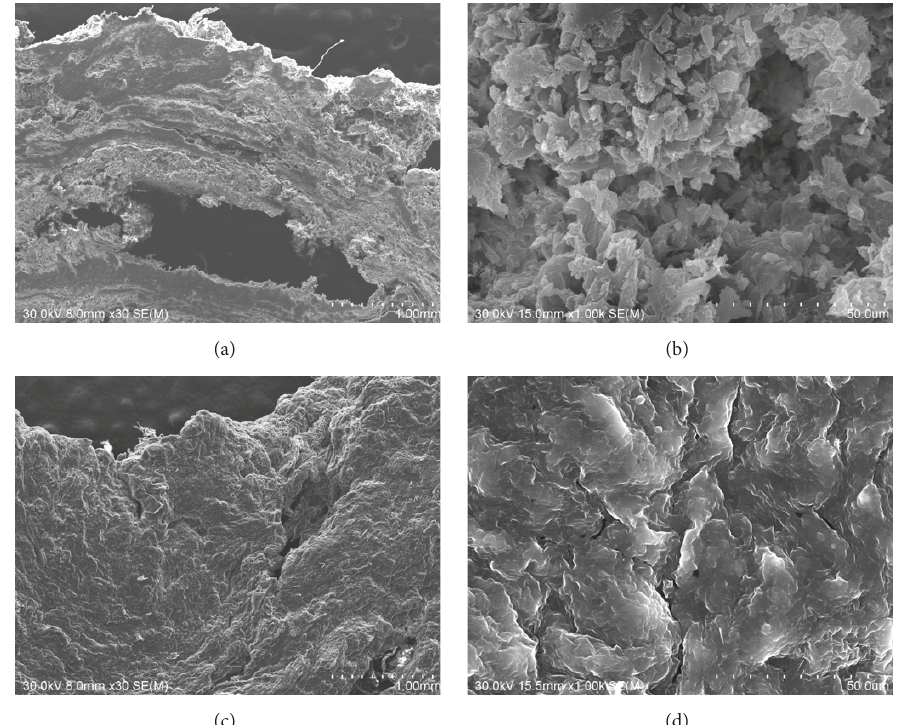
Figure 4: Scanning electron microscopy images. The enterolith piece immersed in water revealed a multilayered structure (a), containing crystalloid microparticles (b). In the enterolith piece immersed in citric acid solution, crystalloid microparticles were absent (c, d).